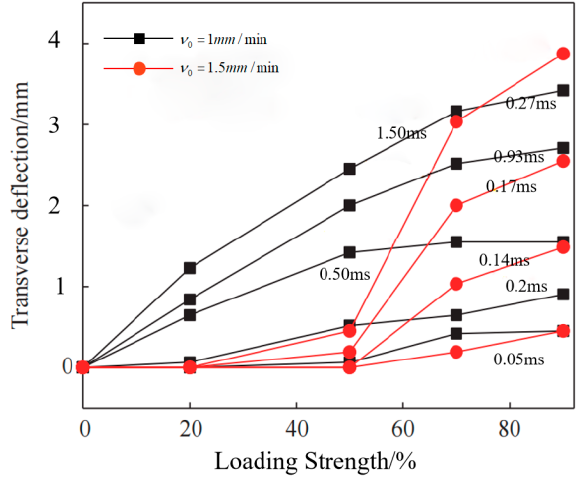
Figure 12. Deformation profiles of laminates at different loading strengths and velocities.